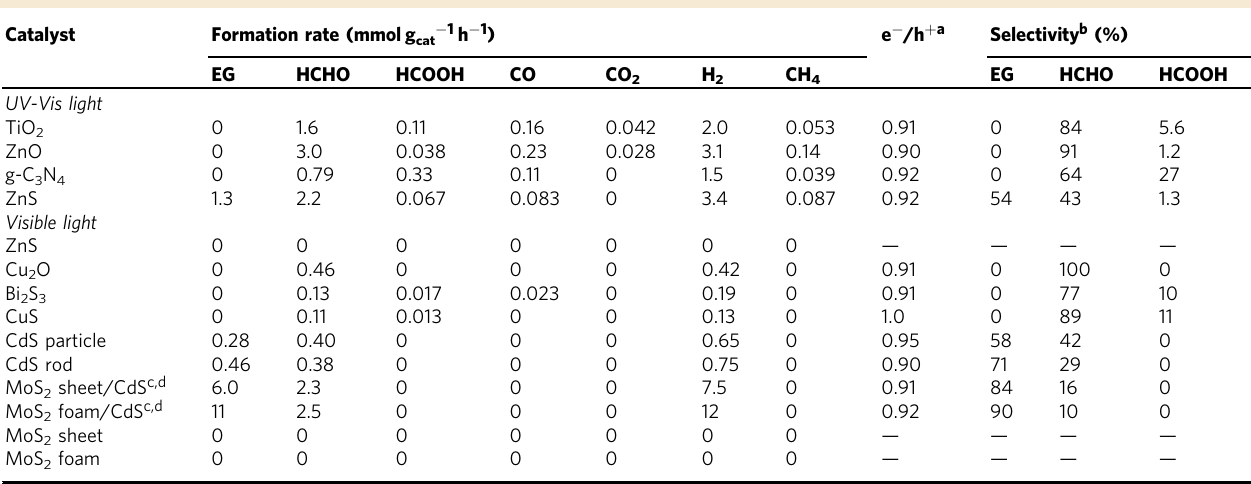
Table 1 Catalytic performances of some typical semiconductors